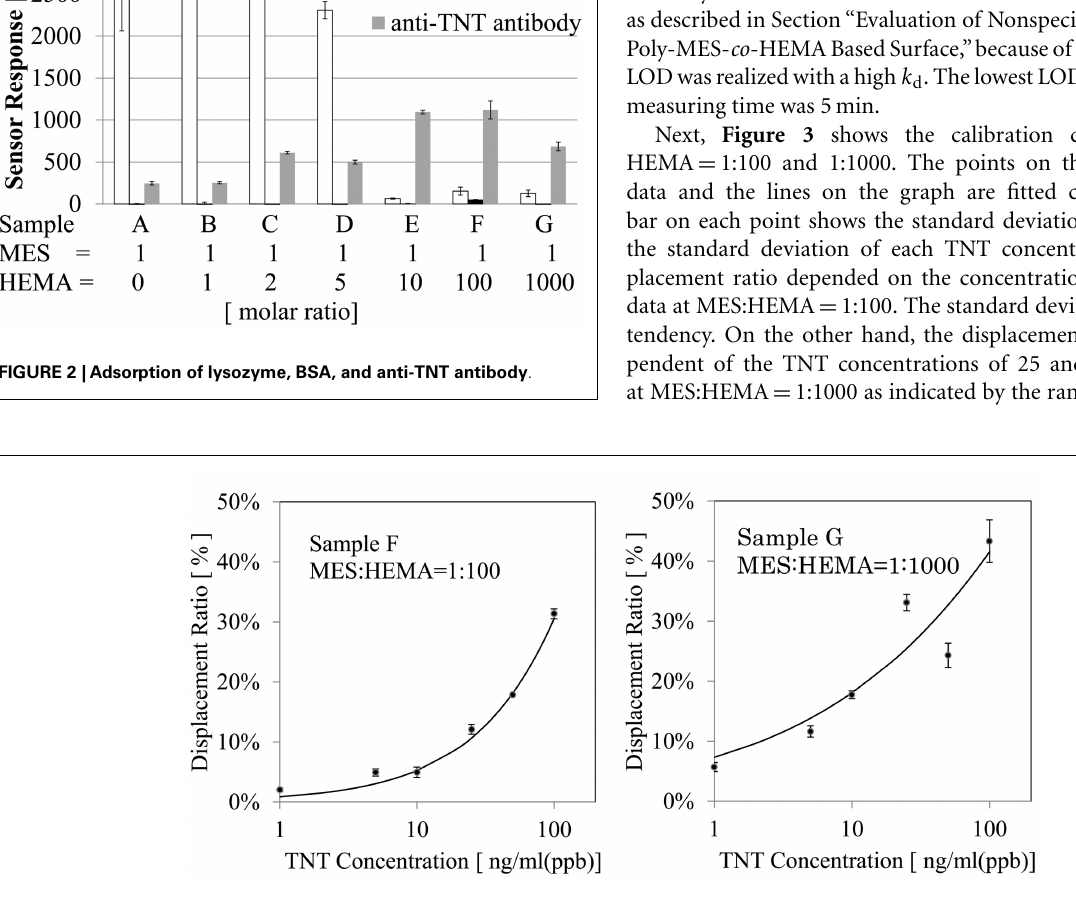
FIGURE 3 | Response characteristic toTNT: calibration curves obtained by displacement assay using 25mg/mL (25ppm) anti-TNT antibody .The error bar shows the SD of the data.